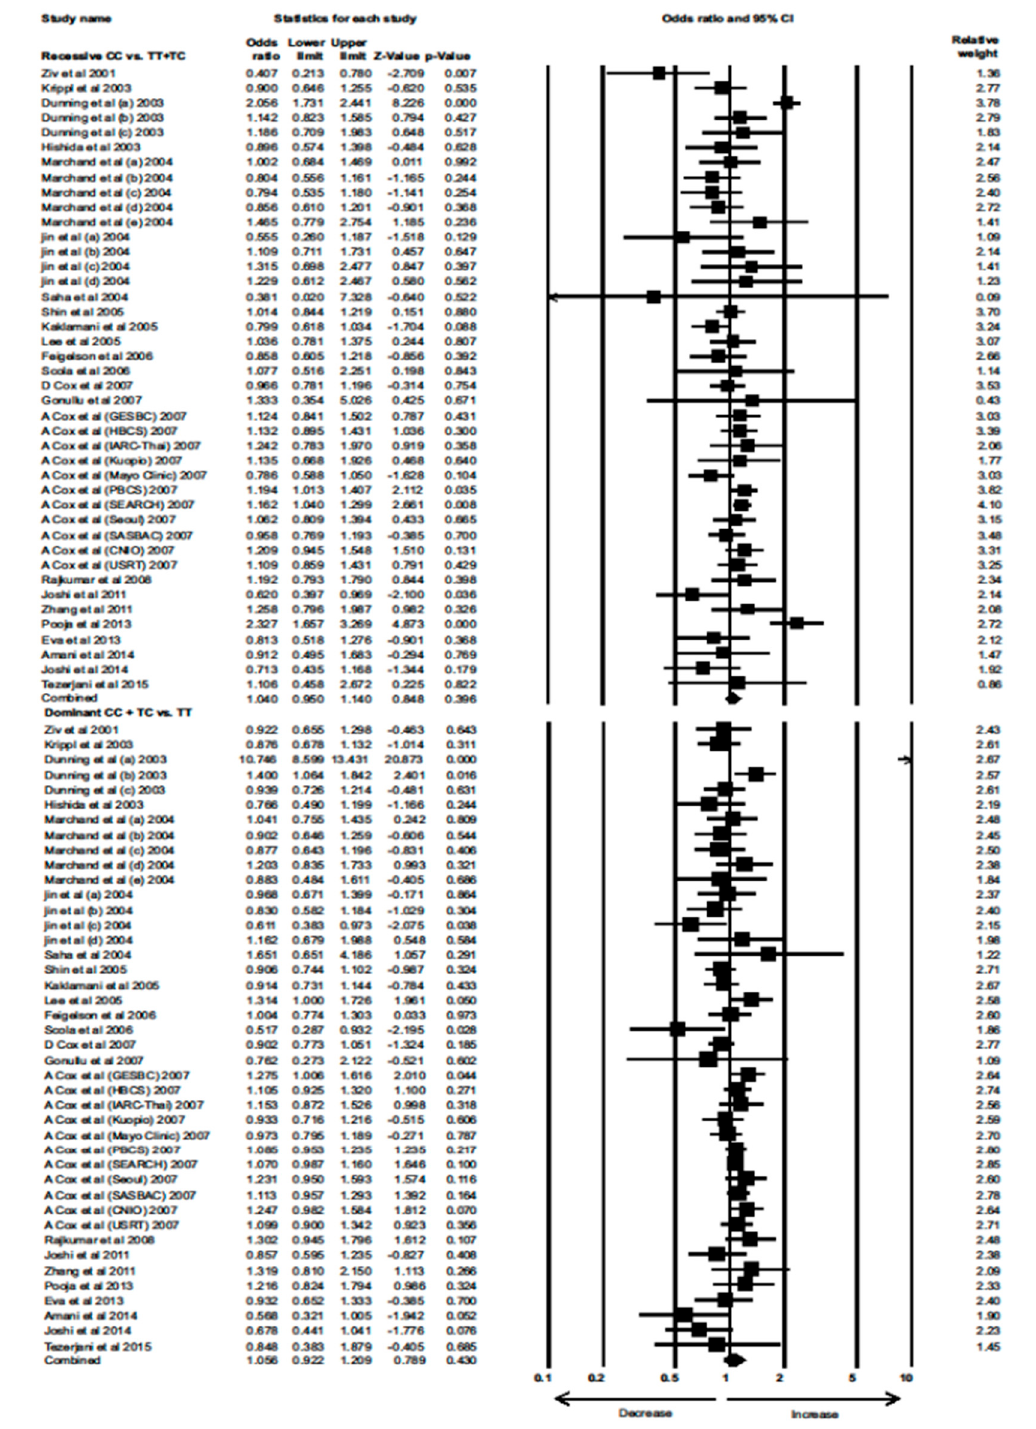
Figure 2. Forest plot of recessive and dominant genotypic analyses of the TGF- β 1 29T > C polymorphism and assessment of its association with BC risk using combined odds ratios (ORs) and 95% confidence intervals (CIs) of the ORs. Black squares represent the ORs of the individual studies, and horizontal lines indicate the 95% CIs of the ORs.